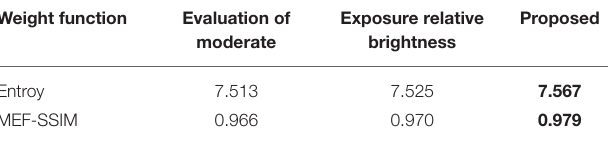
TABLE 3 | Ablation experiment of weight function.